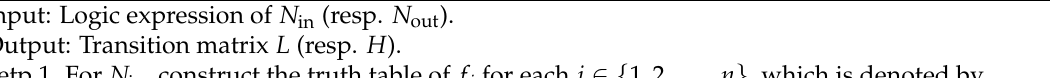
Algorithm 1 Algorithm for converting the logic expression to the algebraic expression of BCN